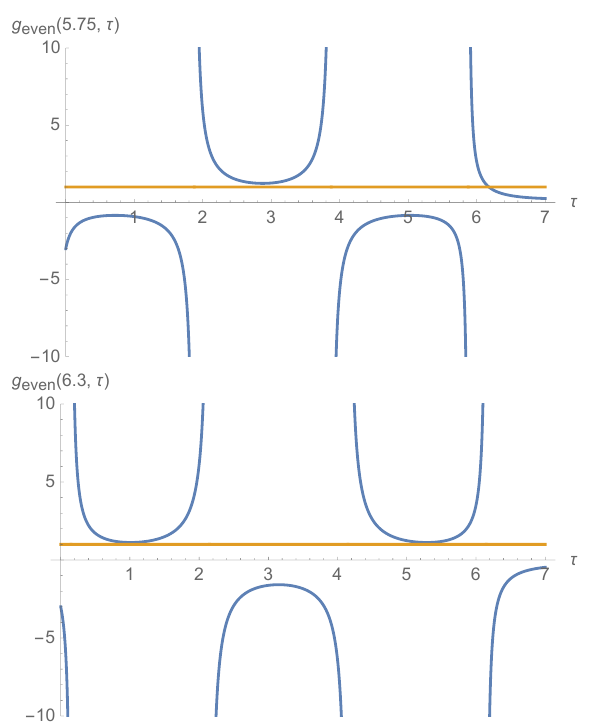
Figure 10. A plot g even ( (cid:28) ) and 1 for d = 5 : 75 (top) and d = 6 : 30 (below) indicating that some eigenvalues become complex outside the range 5 : 79 < d < 6 : 26.